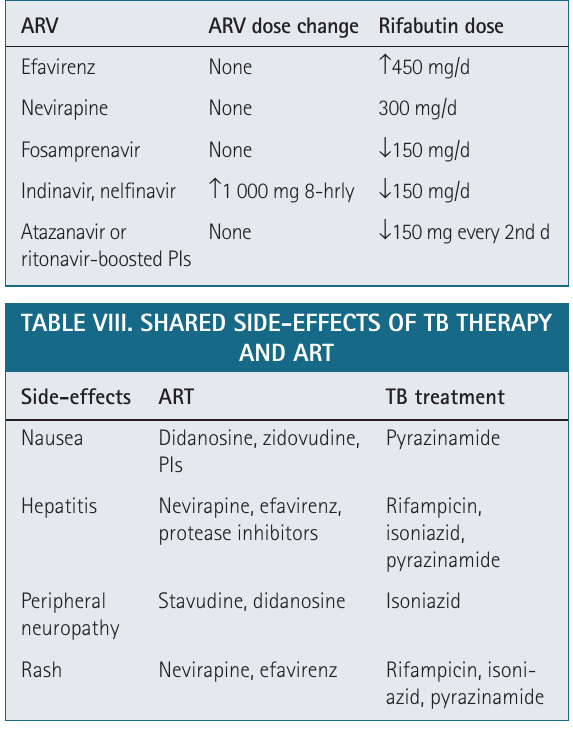
tAble Vii. dosiNG of ARVs ANd RifAbutiN WheN PRescRibed coNcoMitANtly